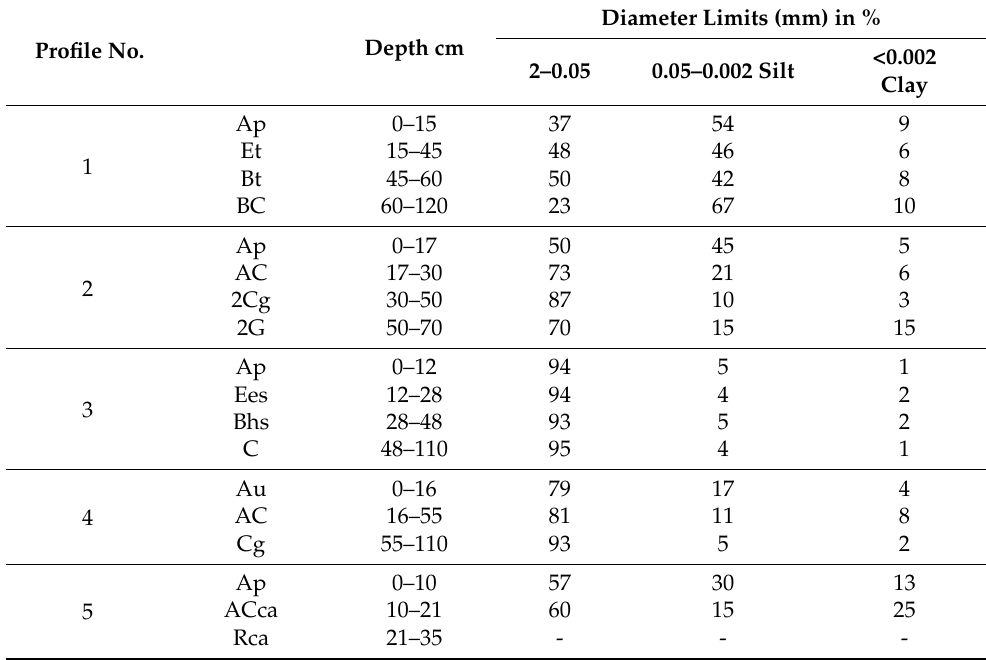
Table 3. Grain size composition of analysed soils (wg PTG 2008 and USDA).